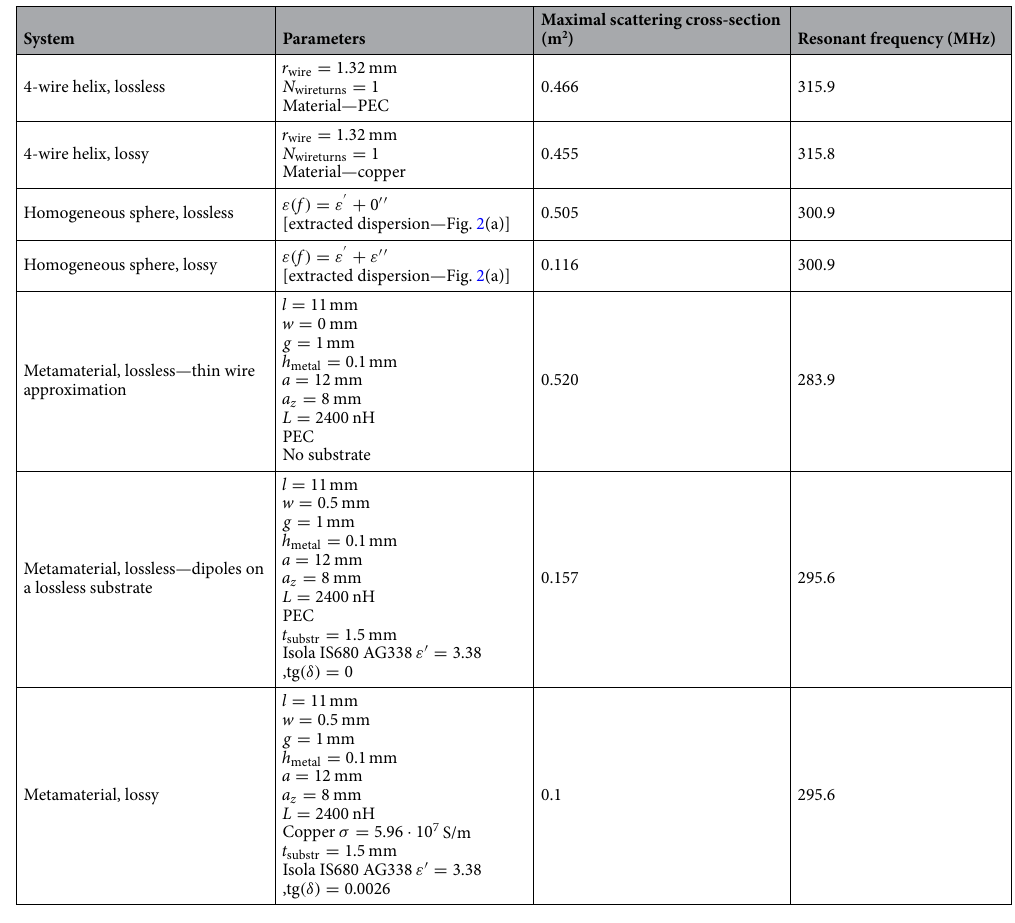
Table 2. Comparison of scattering performances between different spherical structures with all spheres’ radius R = 60